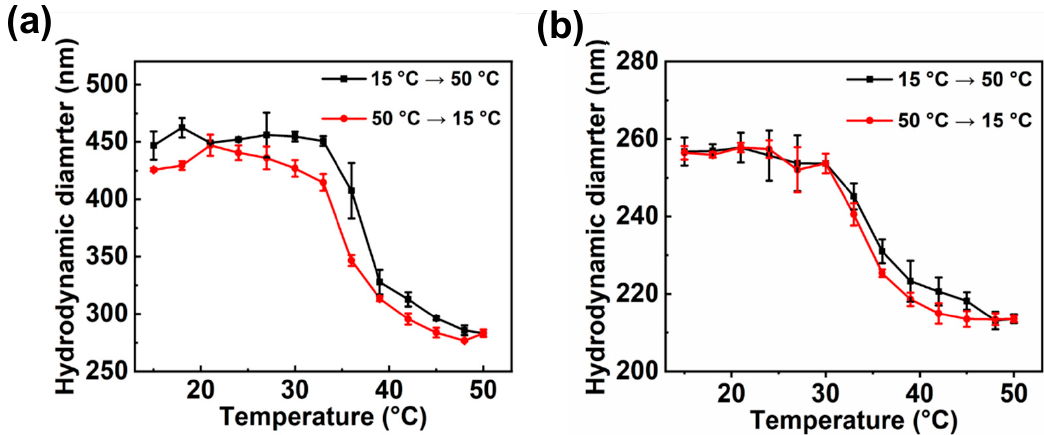
Figure 4. Diameter of ( a ) PSV@PSS-b-PNIPA and ( b ) PSV@PNIPA-b-PSS with temperature.